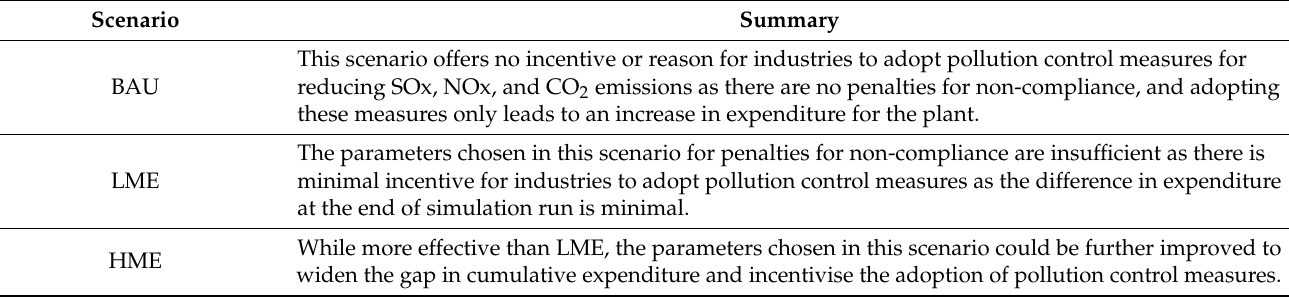
Table 3. Observations from the experiment